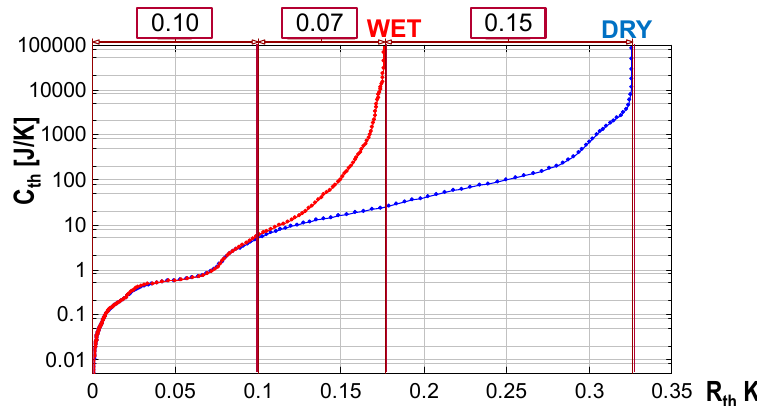
Figure 26. Structure functions of the lower T1 IGBT on wet and dry surfaces.